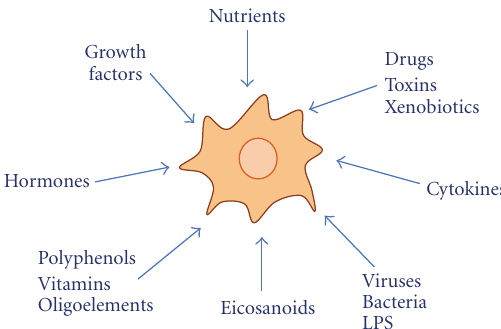
Figure 1: Cells are integrated networks constantly responding to environmental stimuli. The ability to recognize changes in environmentalconditionsand to adapt themselves to those changes, is essential for the viability of cells, and changes in quality and quantity of dietary molecules are the most frequent in the course of the